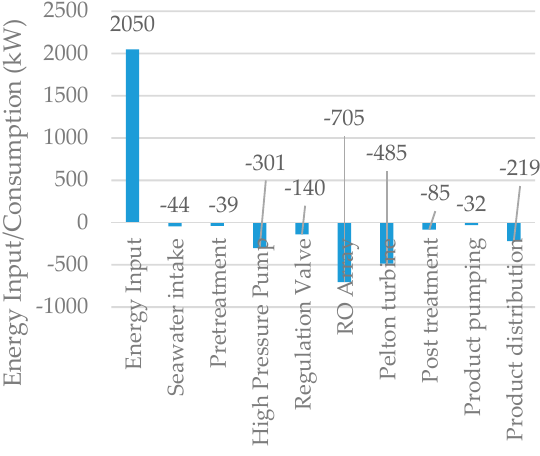
Figure 8. Exergy balance of a seawater reverse osmosis unit with an energy recovery